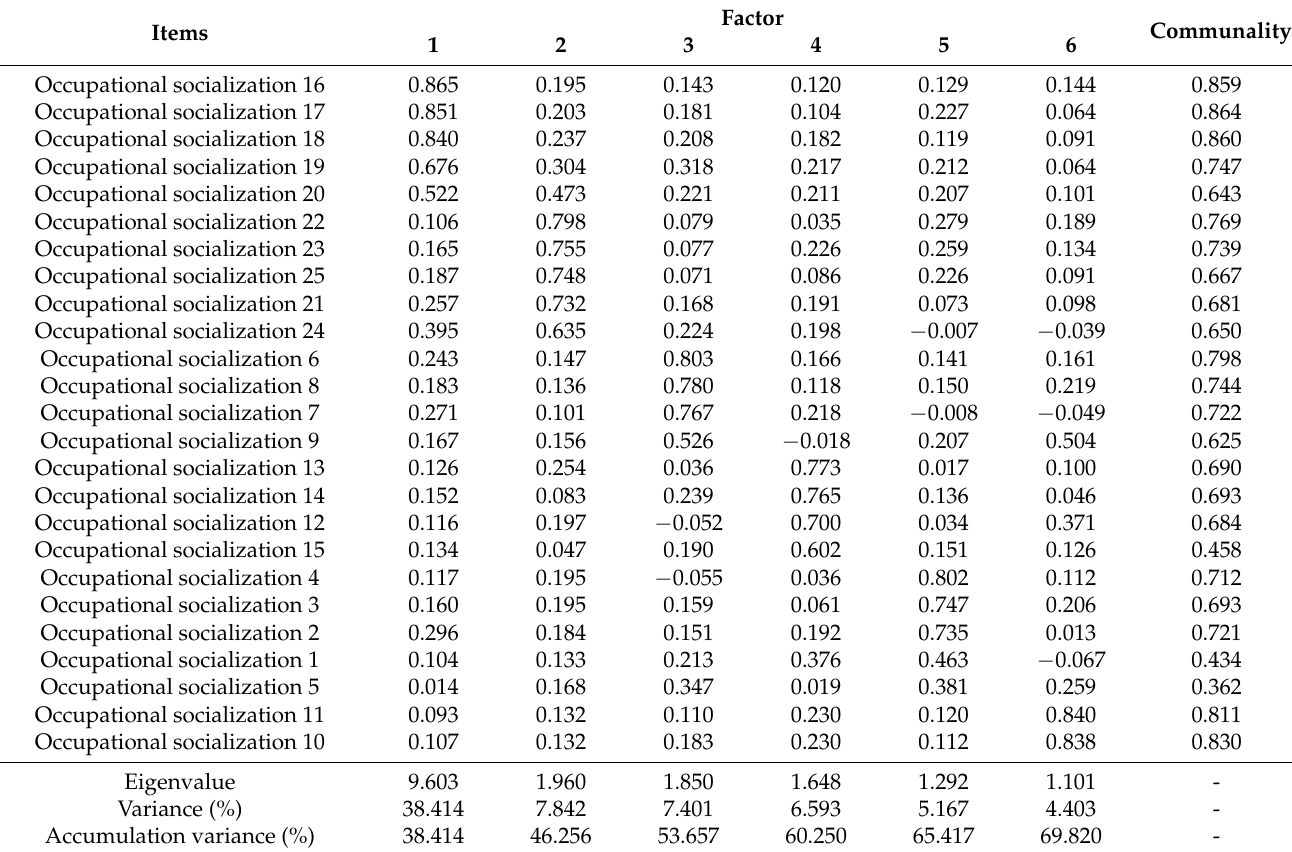
Table 2. The results of exploratory factor analysis.